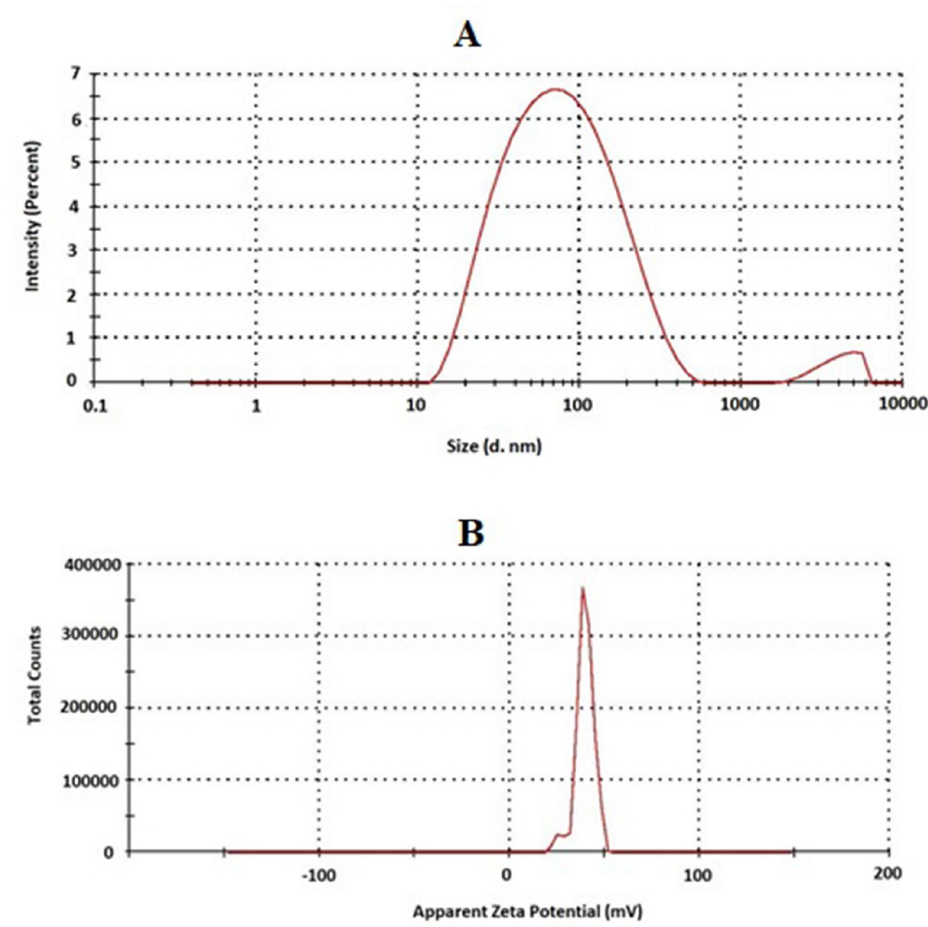
Fig 3. Size (A) and zeta potential (B) distribution of RLX-TPGS-transferosomes